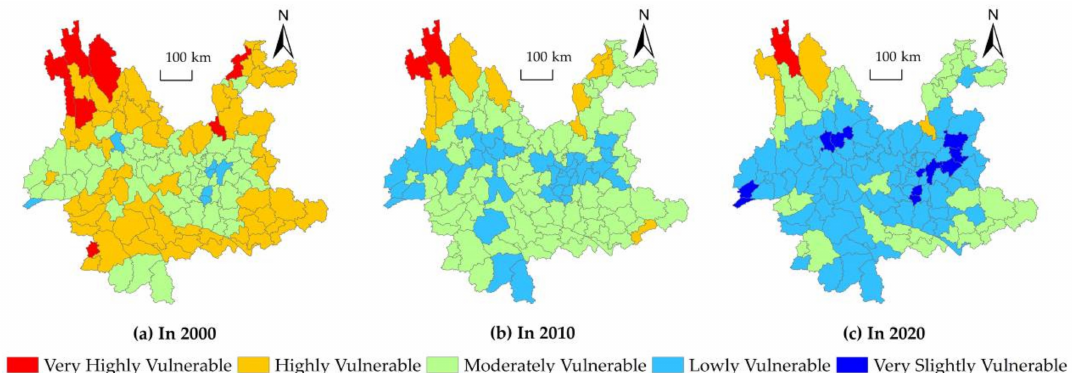
Figure 7. Overall vulnerability evaluation of rural areas in Yunnan Province from 2000 to